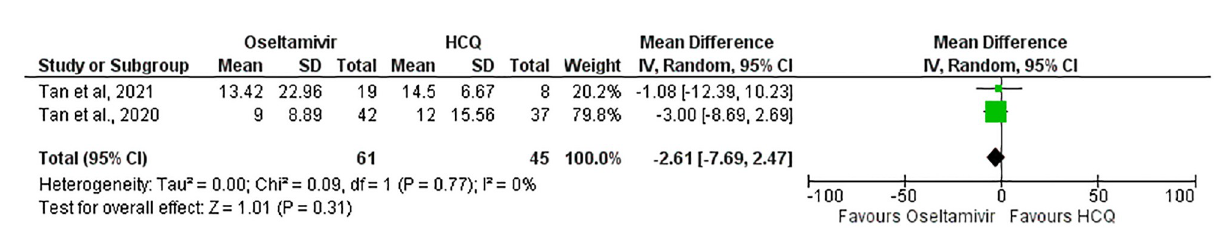
Fig 12. Forest plot. Shows the pooled analysis of the duration of hospitalisation of oseltamivir monotherapy vs HCQ monotherapy.